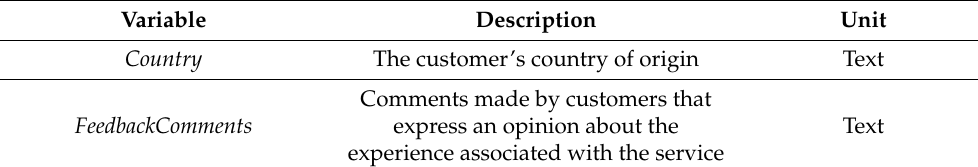
Table 2. Text variables considered in the